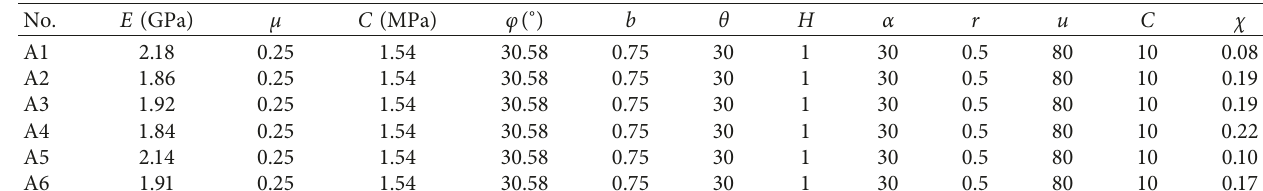
Table 1: Parameters of the subloading surface